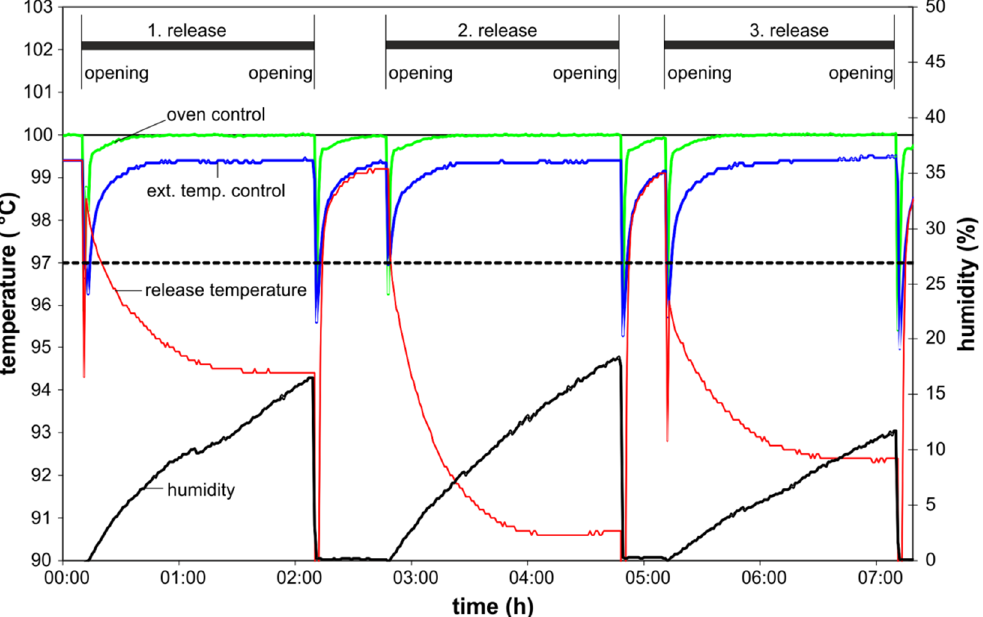
Figure 3. Temperature and humidity in three subsequent release tests in an oven; the black dashed line shows the lower temperature limit for hot plate conditions. Internal oven control: green curve, external verification thermocouple (ext. temp. control); blue curve, humidity: black curve, thermocouple for test solution temperature: red curve. Table 3. Results of the third release of melamine and formaldehyde (mg / dm 2 ) into food simulants under di ff erent migration conditions and the ratio (%) of that migration compared to 3% acetic acid on a hot plate (spoons 1–3 are of the same type as in the first